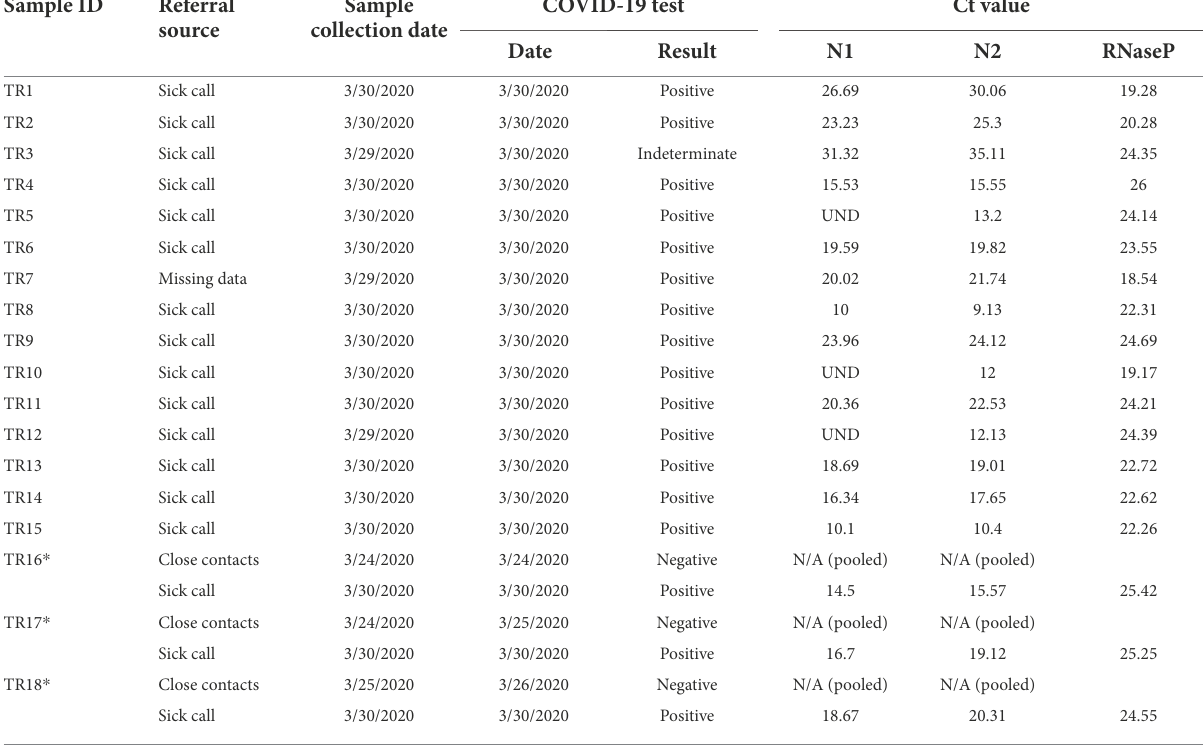
TABLE 1 Metadata of samples included in